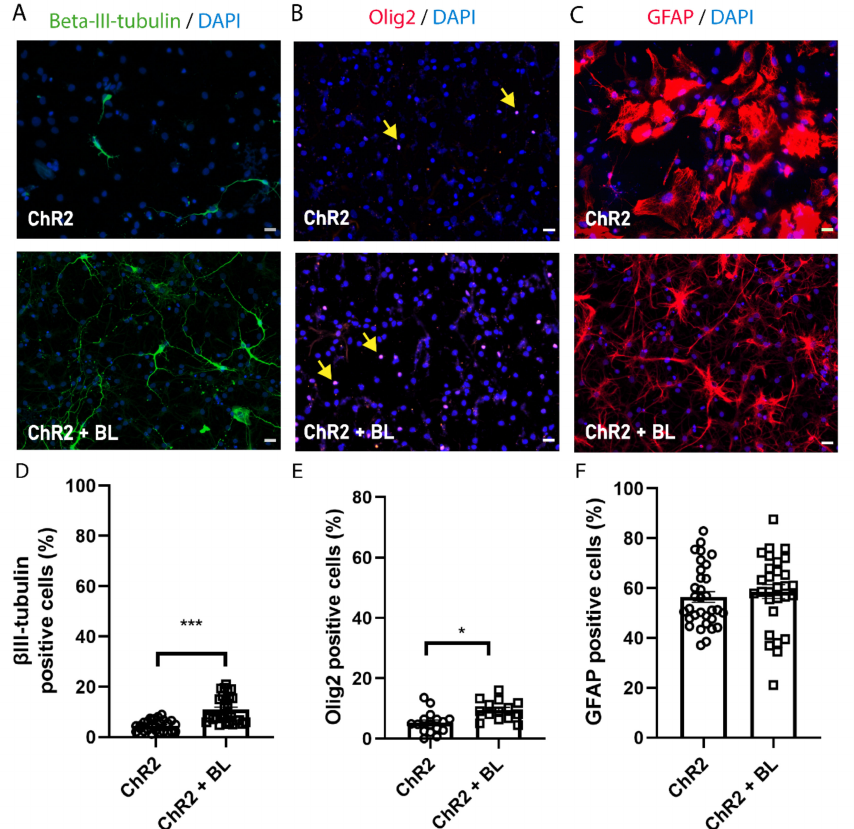
Figure 3. Optogenetic stimulation enhances neuronal and oligodendrocytic but not astrocytic differentiation of NPCs. ChR2-NPCs were differentiated for seven days. ( A – C ) Representative images of immunofluorescence staining for beta- III-tubulin (green; A), oligodendrocyte transcription factor 2 (Olig2) (red; nuclear signal indicated with yellow arrows; B), and glial fibrillary acidic protein (GFAP) (red; C) for unstimulated (ChR2) and BL-stimulated ChR2-NPCs (ChR2 + BL). ( D ) Quantification of the percentage of neurons (beta-III-tubulin-positive cells). Data are expressed as mean ± SEM from three independent experiments (ChR2: 4.5 ± 0.4; ChR2 + BL: 10.9 ± 1) *** p < 0.001 vs. ChR2 determined by Mann–Whitney test. ( E ) Quantification of the percentage of oligodendrocytes (Olig2-positive cells). Data are expressed as mean ± SEM from three independent experiments (ChR2: 5.3 ± 0.9; ChR2 + BL: 9.5 ± 0.9) * p < 0.05, unpaired t -test. ( F ) Quantification of the percentage of astrocytes (GFAP-positive cells). Data are expressed as mean ± SEM from three independent experiments (ChR2: 56.47 ± 2.2; ChR2 + BL: 58.65 ± 2.7). Scale bars, 20 µ